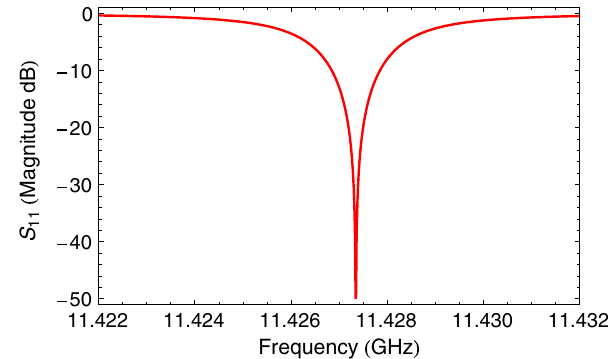
FIG. 5. Calculated reflection as a function of frequency for the PBG-E structure.